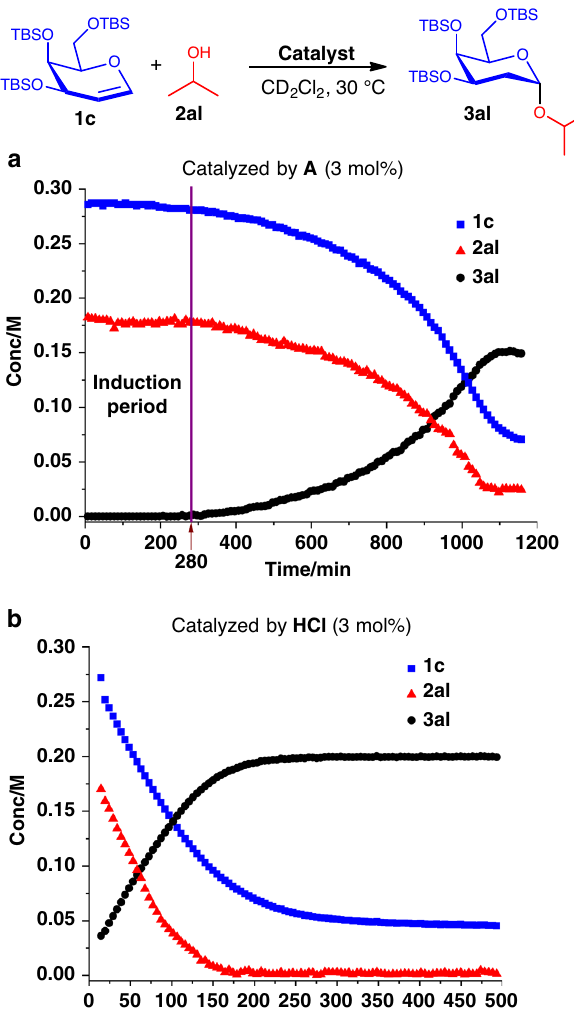
Fig. 6 XB vs strong acid kinetic pro fi le comparison. Comparison of a sigmoidal kinetics under standard conditions with b saturation kinetics with a strong Brønsted